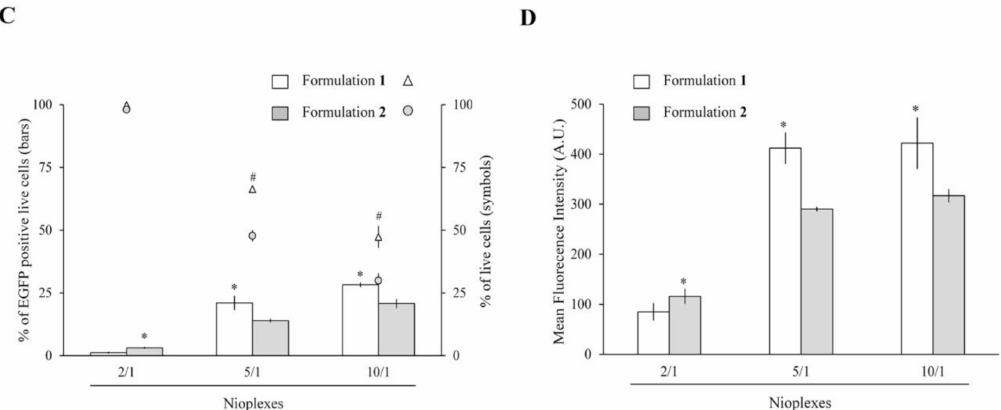
Figure 8. Transfection capacity and cell viability assays. ( A ) Fluorescence intensity over time in CuFi-1 cells transfected with nioplexes based on formulation 1 , 2 and 3 at cationic lipid/DNA mass ratio 5/1. Each value represents the mean ± SD of three measurements. ( B ) Fluorescence microscope images showing EGFP positive CuFi-1 cells transfected with nioplexes based on formulation 1 , 2 and 3 at cationic lipid/DNA mass ratio 5/1 and cellular appearance over time. ( C ) Percentages of EGFP positive live cells (bars) and cell viability (symbols) measured by flow cytometry in CuFi-1 cells 48 h after transfection with nioplexes 1 and 2 at cationic lipid/DNA mass ratios 2/1, 5/1 and 10/1. Each value represents the mean ± SD of three measurements. ( D ) Mean fluorescence intensity values. Each value represents the mean ± SD of three measurements. Statistical significance: * p ≤ 0.05 in transfection and MFI; # p ≤ 0.05 in cell